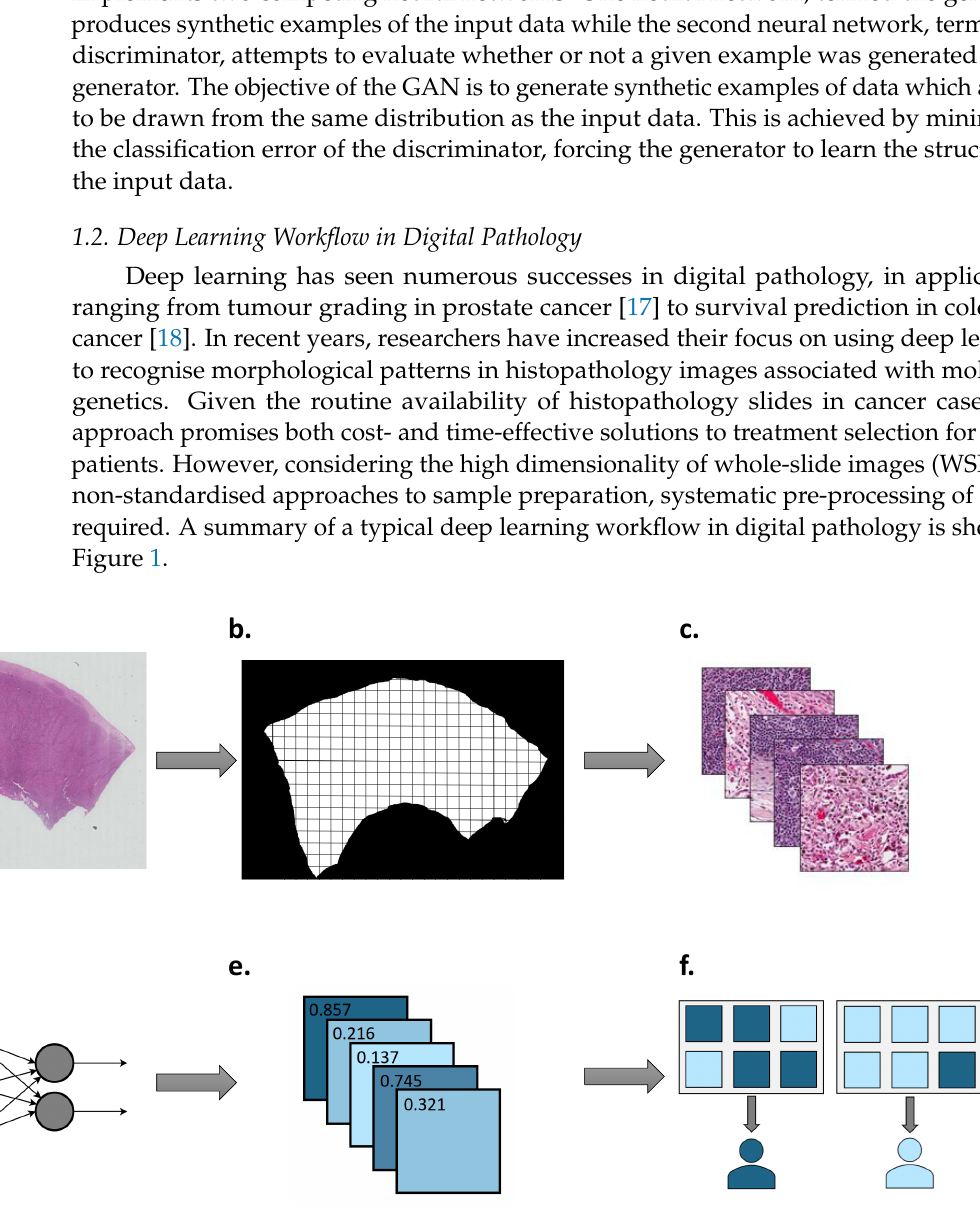
Figure 1. Summary of deep learning workflow in digital pathology. ( a ) Histopathology slides are scanned at various magnifications to generate WSI. ( b ) Tumour region is located and divided into tiles. ( c ) WSI tiles are colour normalised and desired augmentations are carried out. ( d ) Neural network is trained using tiles and corresponding labels. ( e ) Tile- level predictions are returned by the neural network. ( f ) Patient-level predictions are determined by aggregating tile- level